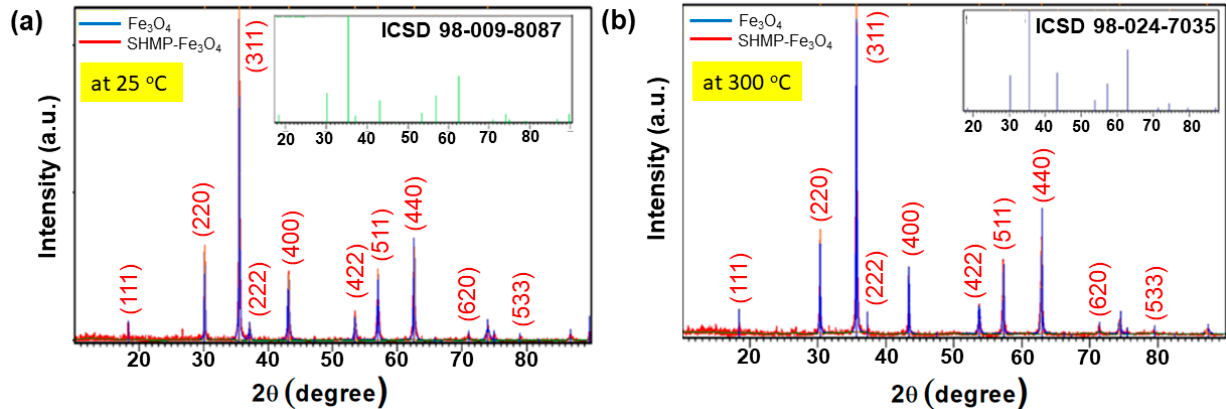
Figure 5. XRD patterns of bare Fe 3 O 4 and SHMP-treated Fe 3 O 4 particles at ( a ) room temperature, 25 °C (inset: XRD pattern of ICSD 98-009-8087) and ( b ) 300 °C calcined (inset: XRD pattern of ICSD 98-024-7035), respectively.